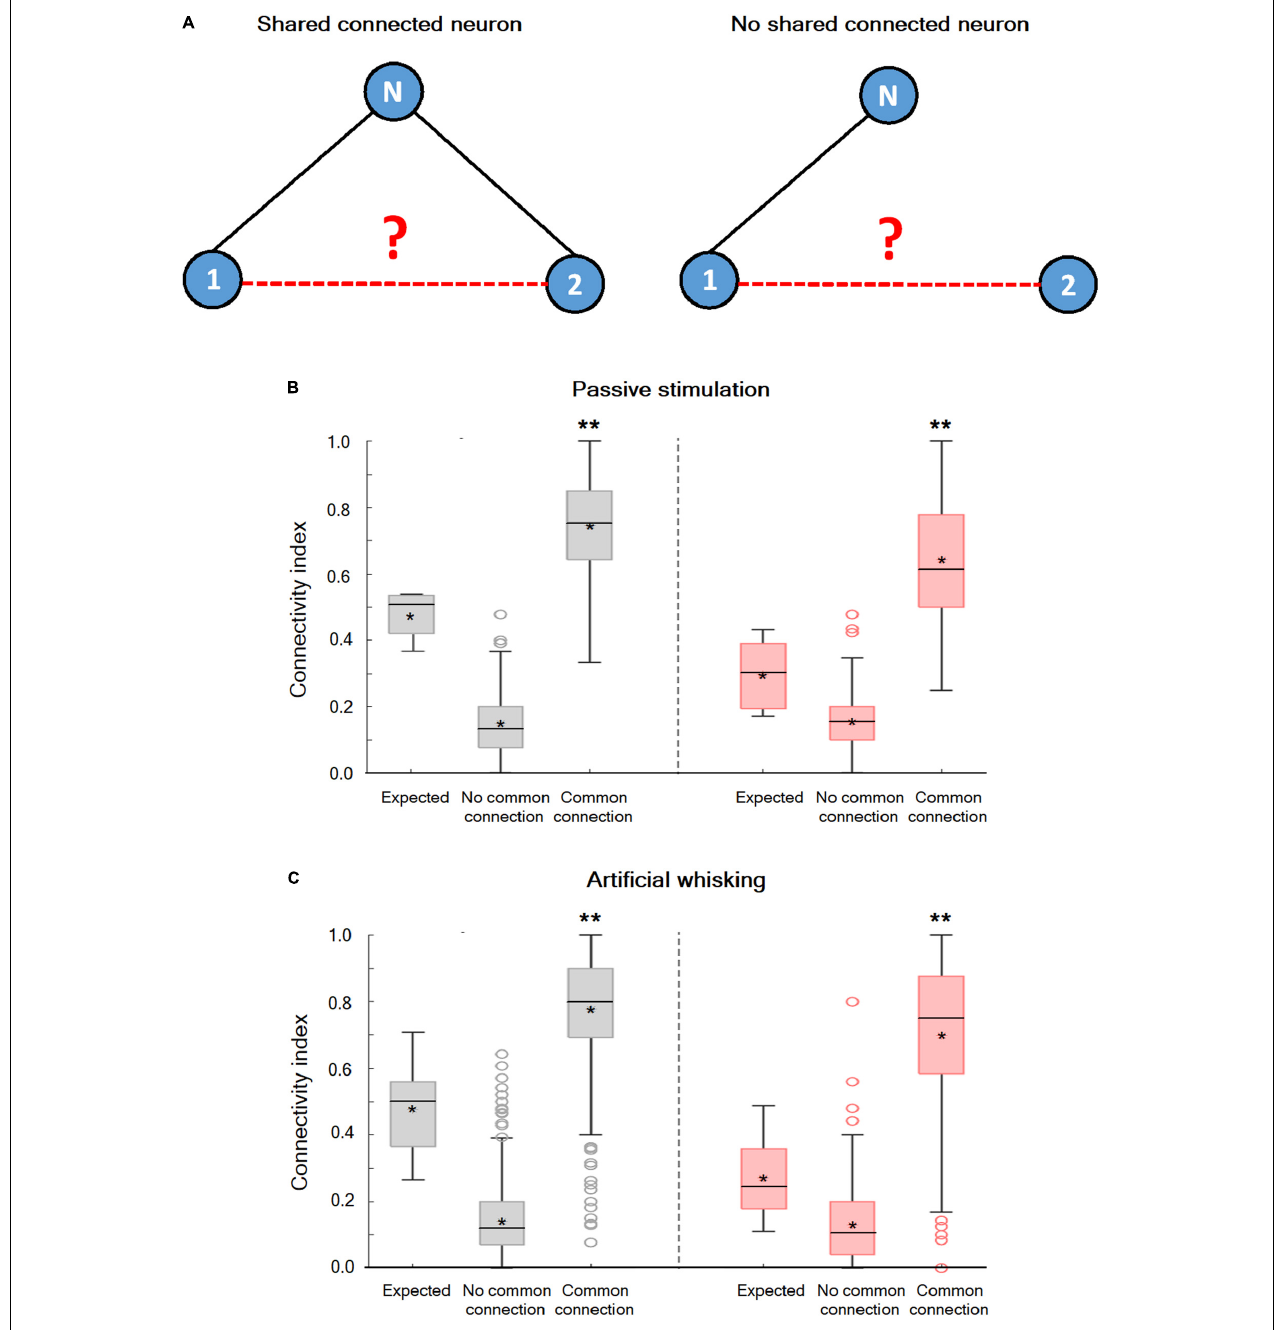
FIGURE 5 | Non-random connectivity in the wS1 barrel cortex during the spontaneous pre-stimulus and activated states. (A) A Diagram of three hypothetical neurons explaining the concept of the performed analysis. In the left panel, units 1 and 2 share a common connection with unit N while in the right panel no common connection exists. (B) Boxplots of the connectivity index during spontaneous pre-stimulus (gray) and passive ramp-and-hold whisker activation (red) for neuronal pairs that share a common recorded connected neuron (common connection), neuronal pairs that do not share any common recorded connected neuron (no common connection), and the expected connectivity index assuming random connectivity (expected: 169 units from 5 rats). The middle line in the boxplots represents the median value and the asterixis represents the mean value. A value of ** p < 0.01 was obtained with the t -test for comparison of neurons with common connections and neurons with no common connections, as well as ANOVA comparing all three groups. (C) Box plots of the connectivity index during spontaneous pre-stimulus (gray) and artificial whisking against sandpaper (red) for neuronal pairs that share a common recorded connected neuron (common connection), neuronal pairs that do not share any common recorded connected neuron (no common connection), and the expected connectivity index assuming random connectivity (173 units from 5 rats). The middle line in the boxplots represents the median value and the asterixis represents the mean value. A value of ** p < 0.01 was obtained with the t -test for comparison of neurons with common connections and neurons with no common connections. * p < 0.05.